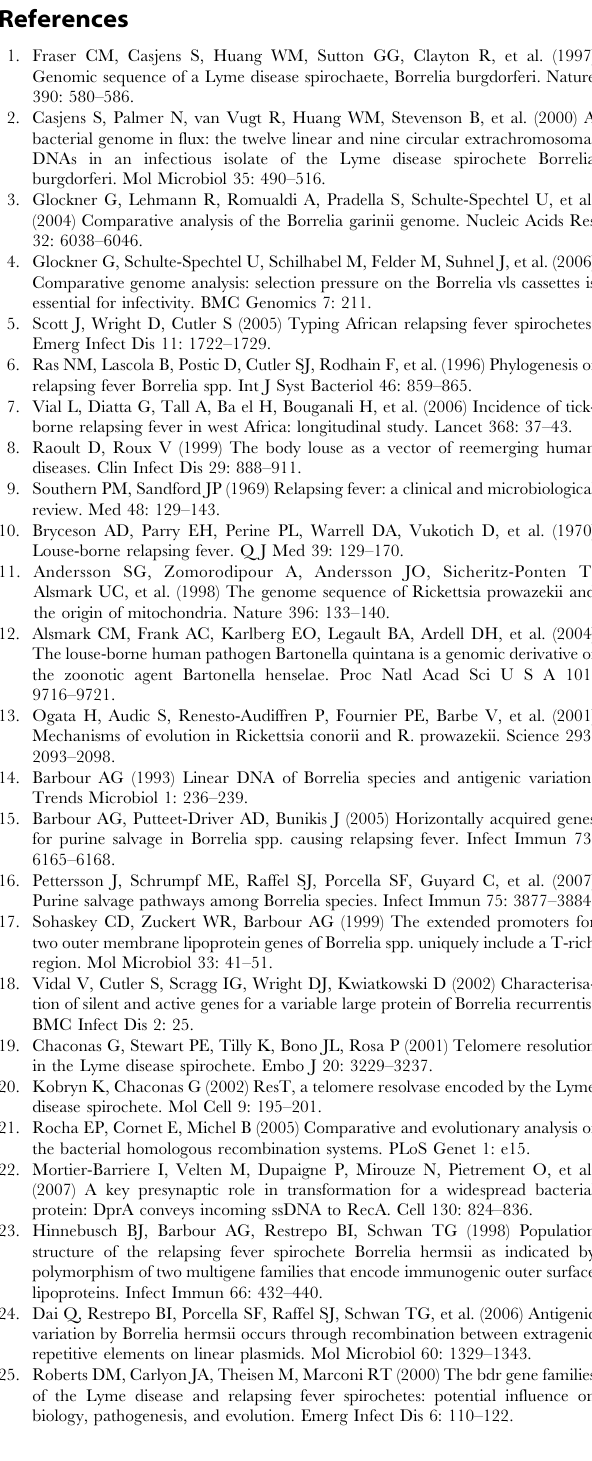
Table S4 Parameters of the codon models used in this study. Found at: doi:10.1371/journal.pgen.1000185.s011 (0.02 MB Dataset S1 List of the predicted proteins, in fasta format, of B. duttonii , B. recurrentis , B. burgdorferi , B. garinii and B. afzelii grouped in